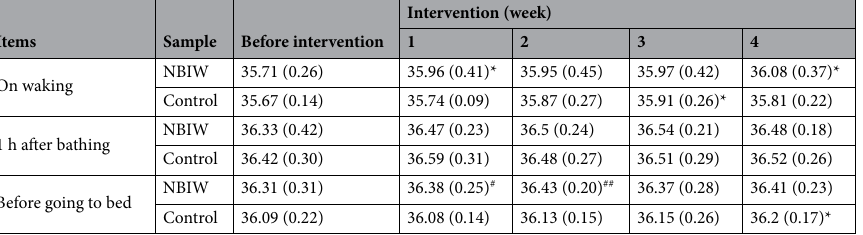
Table 4. Body temperature (stratified analysis by participants with body temperature below 36 °C on waking). NBIW neutral bicarbonate ionized water. NBIW: n = 8, Control: n = 6. Values are shown as mean ( SD ). Within- group comparison: Significant differences were found compared with before the intervention (* p < 0.05: Wilcoxon signed rank test). Between-group comparison: Significant differences between group ( # p < 0.05, ## p < 0.01: Wilcoxon rank sum test).